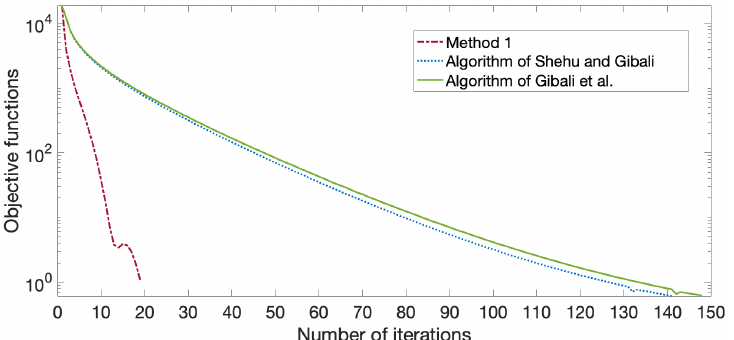
Figure 2. Graph of objective function values and number of iterations for P = 2048, K = 1024, m = 30 when MSE < 10 − 5 .